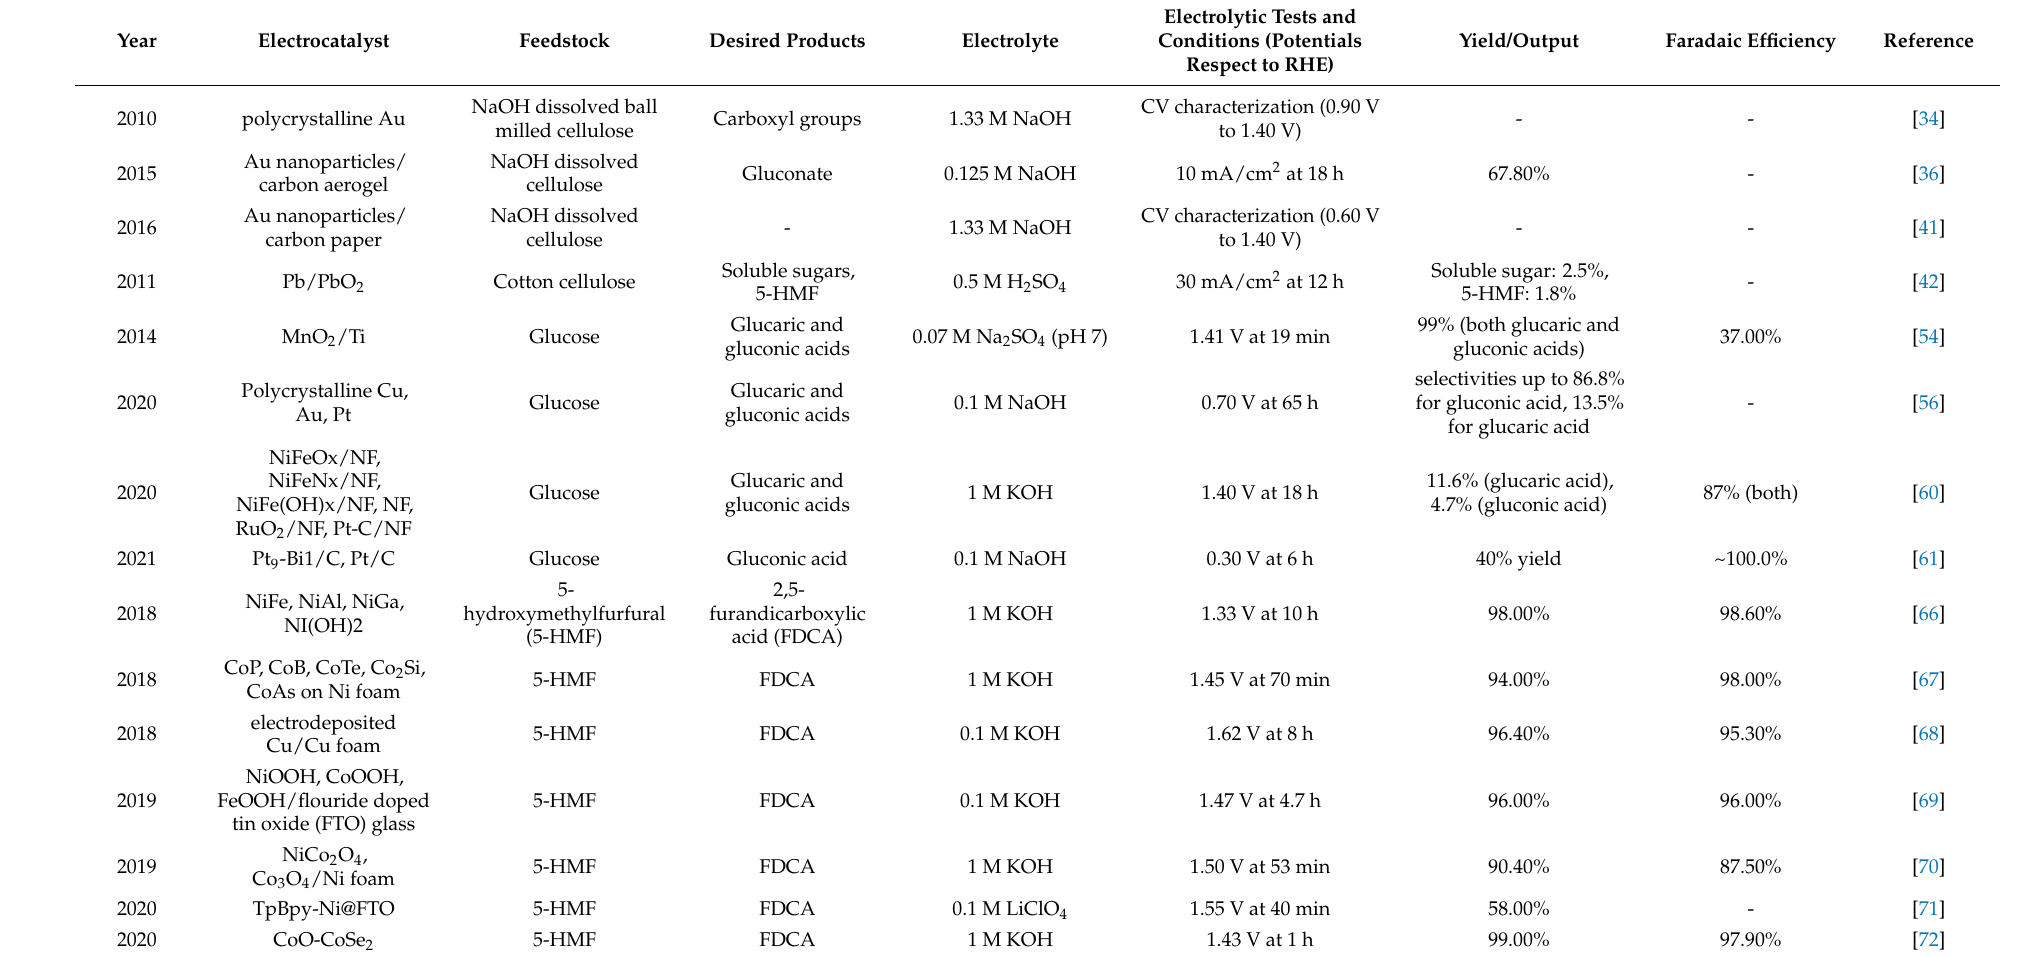
Table 1. Studies investigating electroreforming of biomass at the